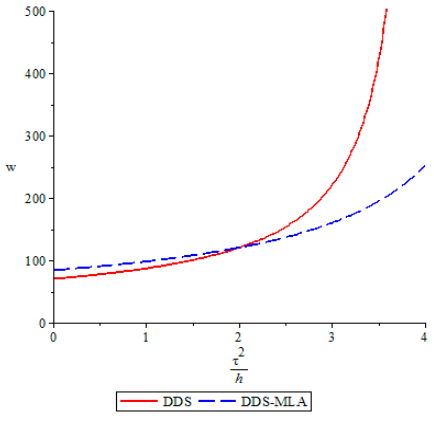
Figure 2. The impact of green efficiency coefficient on wholesale price.